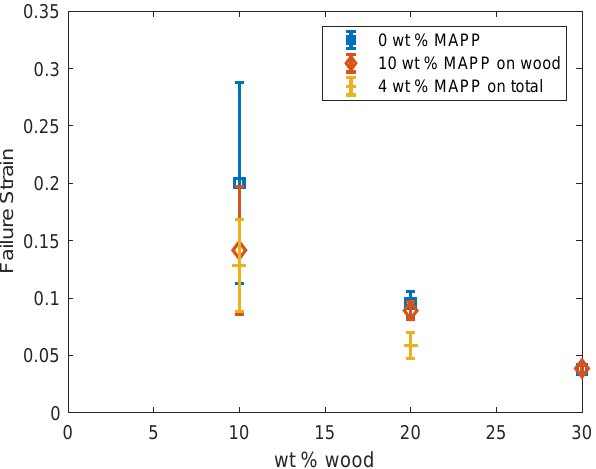
Figure 7. Failure strain as a function of filler percentage for various